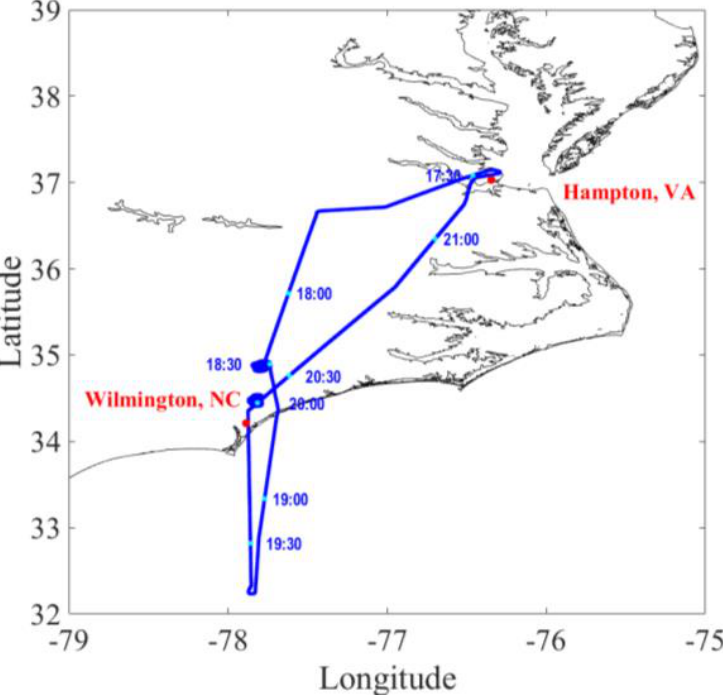
Figure 5. Flight ground track (blue) recorded using GPS for NASA B-200 aircraft on 17 September 2019 between Hampton, VA (37.0299° N, 76.3452° W) and Wilmington, NC (34.2104° N, 77.8868° W) for 2- µ m IPDA lidar airborne testing. Sunsets was at 7:16 PM local time at Wilmington on that